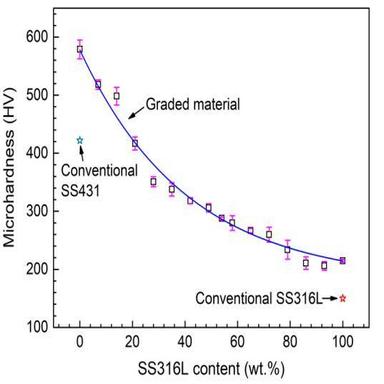
Microhardness values of the graded material with the SS316L content.